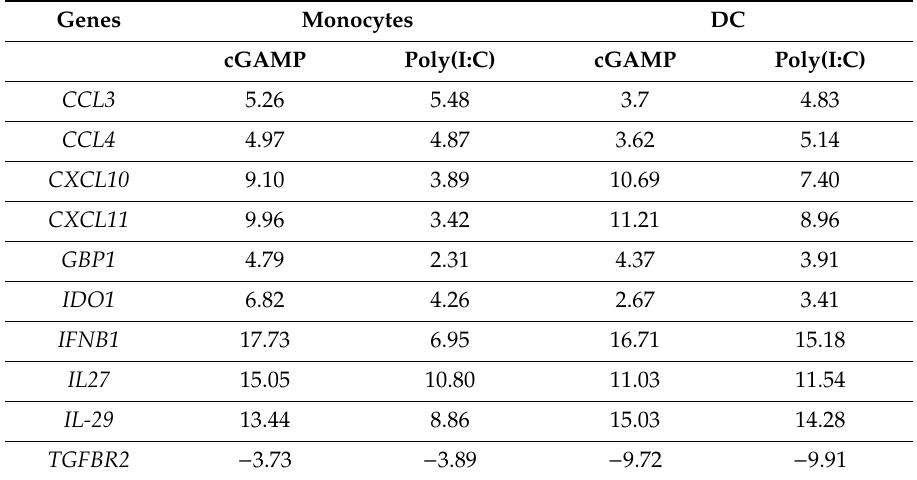
Signed fold-change table of di ff erentially expressed genes (DEG) that were common between human DC ( n = 4–5) and CD14 + monocytes ( n = 4–5) upon stimulation with cGAMP or poly(I:C). Gene expression was quantified using the NanoString nCounter